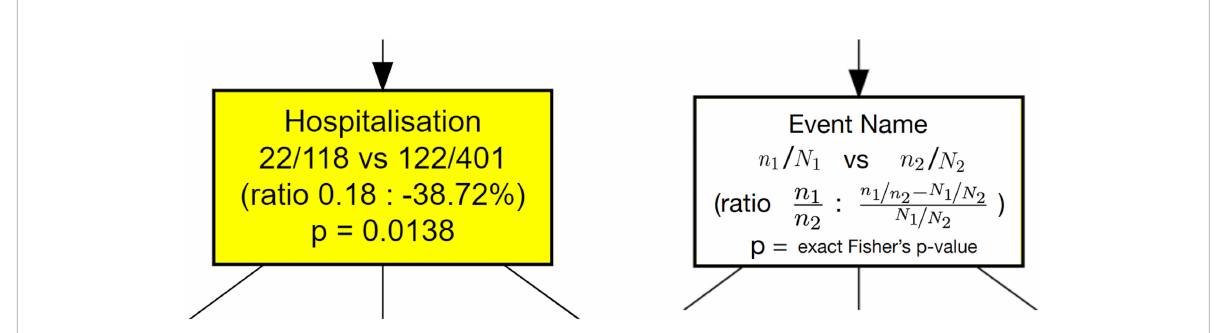
FIGURE 2 Node contents for a D PM analysis of a strati fi ed dataset. An example is shown on the left and the corresponding de fi nitions on the right. The initial dataset is split in two strata with cardinalities N 1 and N 2 . Each node shows the number of hits from both strata, noted n 1 , n 2 , plus the ratio of hits, n 1 / n 2 , and the relative change of this ratio compared to the ratio of initial cardinalities, N 1 / N 2 . At the bottom, a Fisher ’ s exact test measures if there is a signi fi cant difference between the hit ratio and the original cardinality